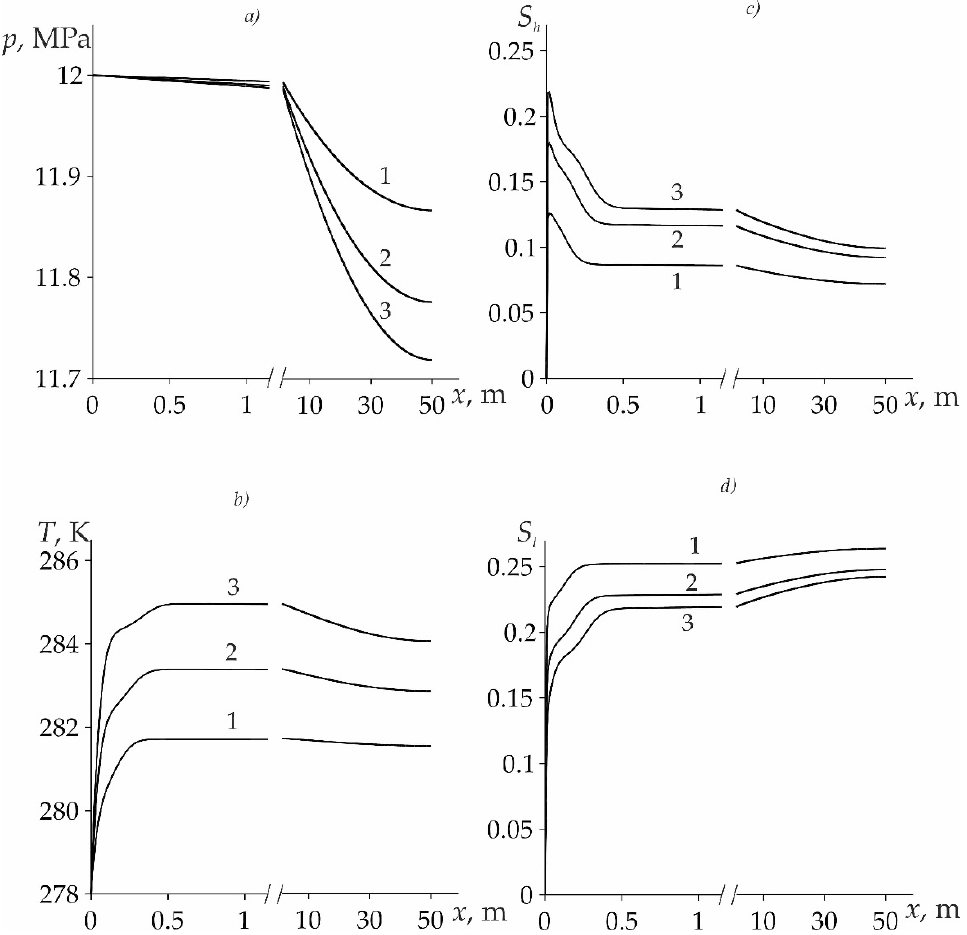
Figure 4. Distributions of pressure ( a ), temperature ( b ), hydrate saturation ( c ) and water saturation ( d ) at: m = 0.1 (1), 0.15 (2), 0.2 (3).